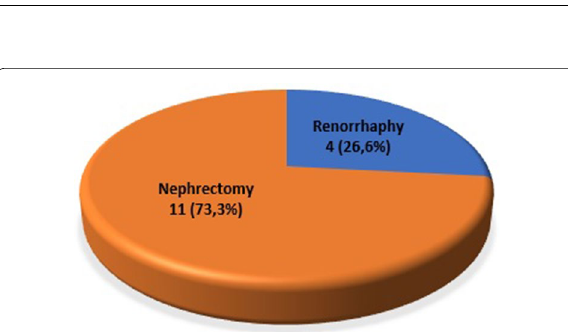
Fig. 2 Type of operative management in renal